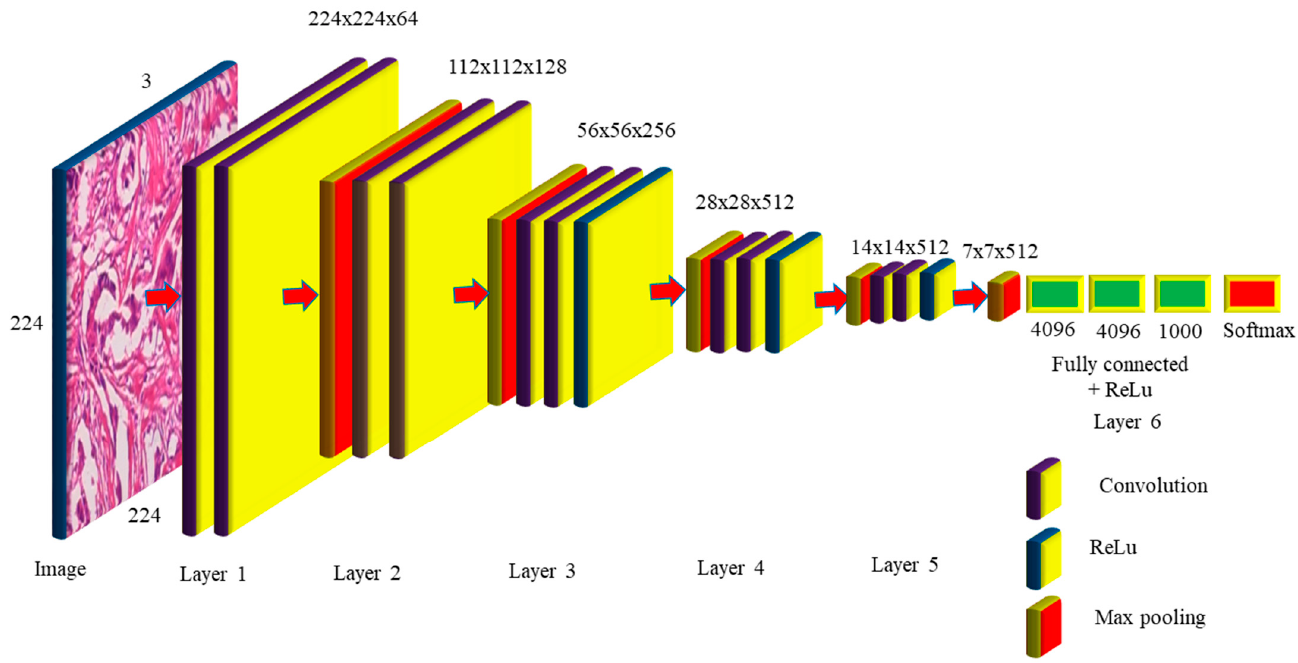
Figure 4. VGG-16 Network Architecture Map.